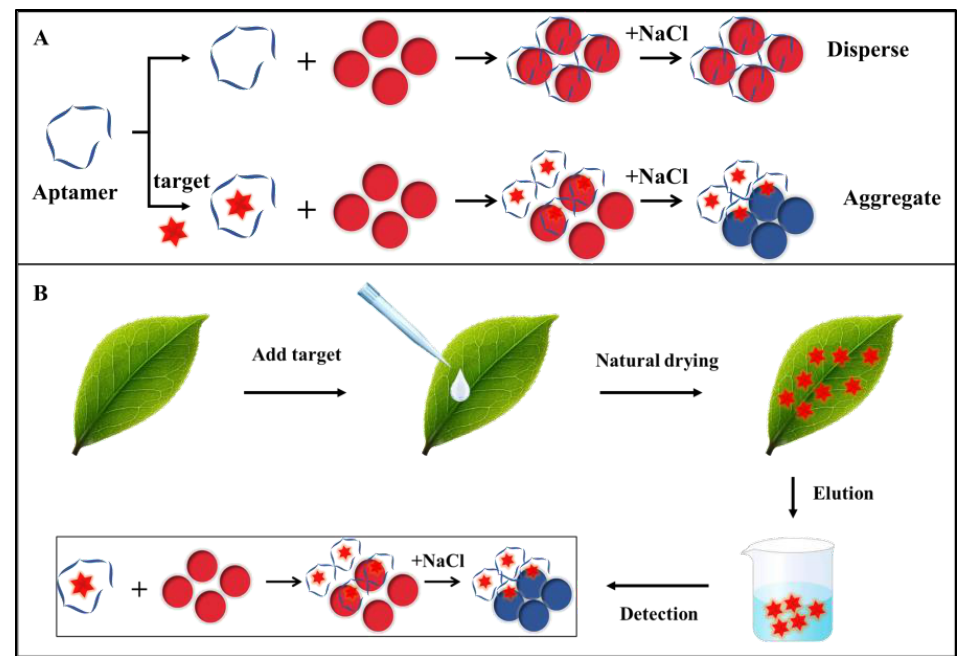
Figure 6. Schematic diagram of ( A ) color development principle of AuNPs and ( B ) surface detection of actual tea leaf samples.